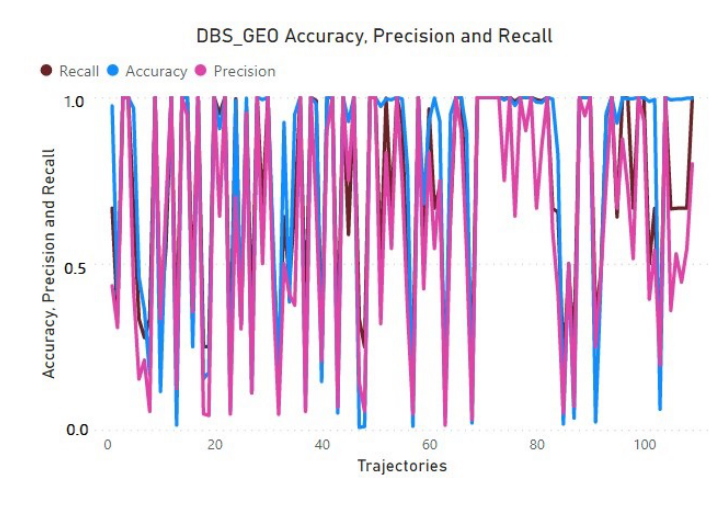
Figure 7. LOF performance for the GEO dataset: precision, recall, and accuracy.